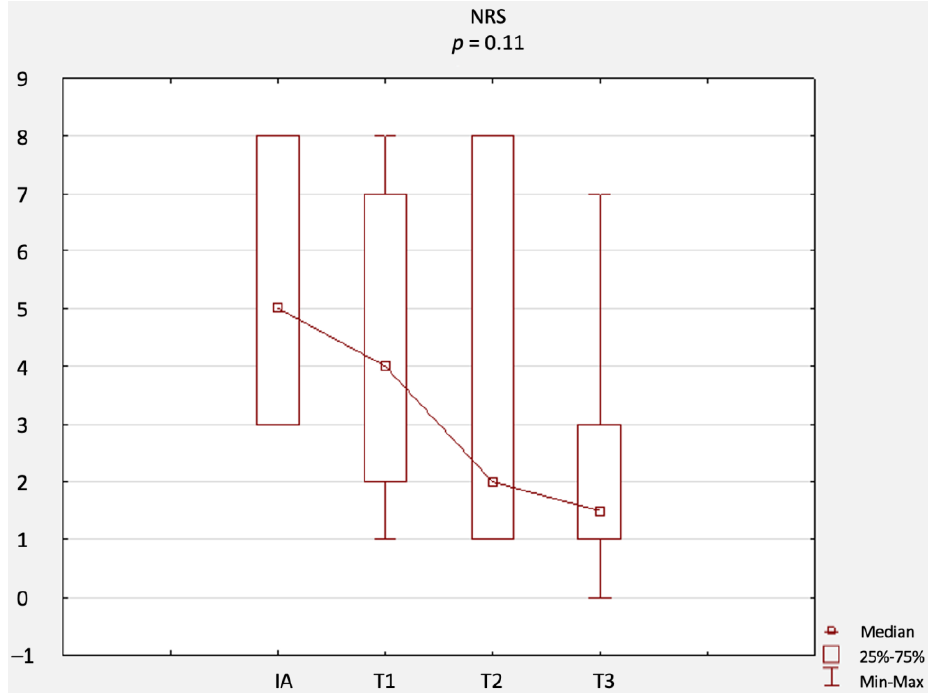
Figure 2. Comparison of NRS results at IA, T1, T2, and T3. Abbreviations: NRS, numeric rating scale; IA, initial assessment; T1, first-month assessment; T2, second-month assessment; T3, third- month assessment.